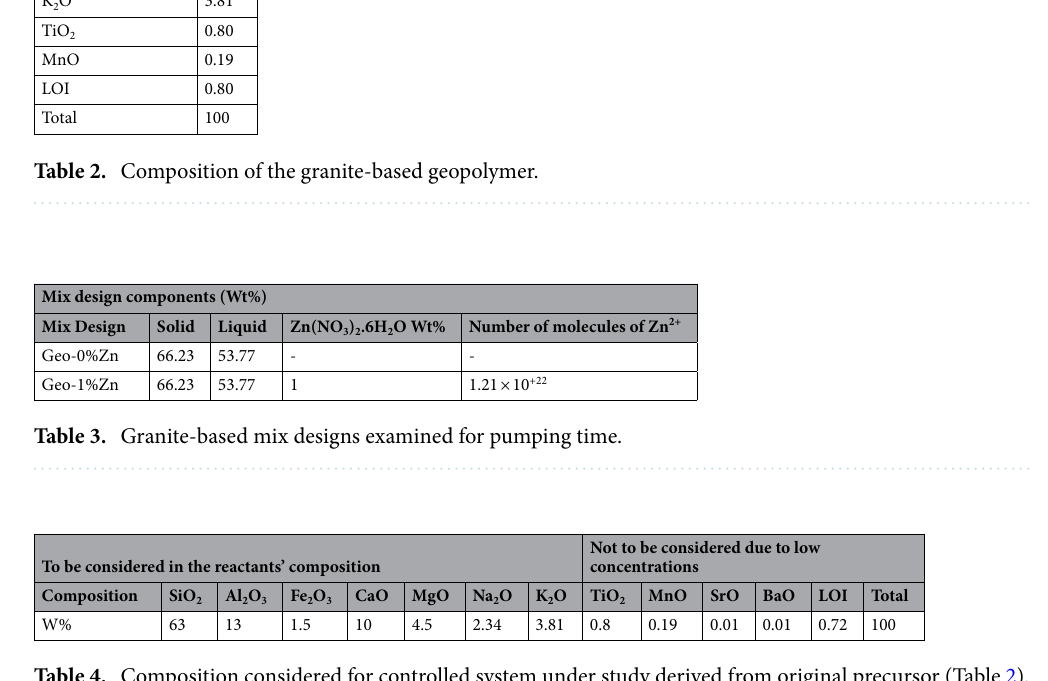
Table 4. Composition considered for controlled system under study derived from original precursor (Table